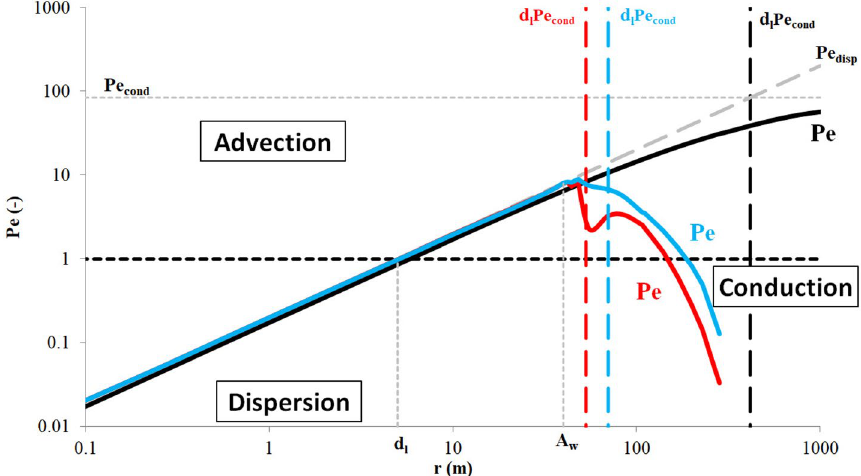
Fig. 6 Peclet number at the end of the injection (red colour) and at the end of the back injection (blue colour) in the tenth year of operation. Central well is located at 0 m and the auxiliary well is represented with A w . Black and grey lines represent the perfectly radial